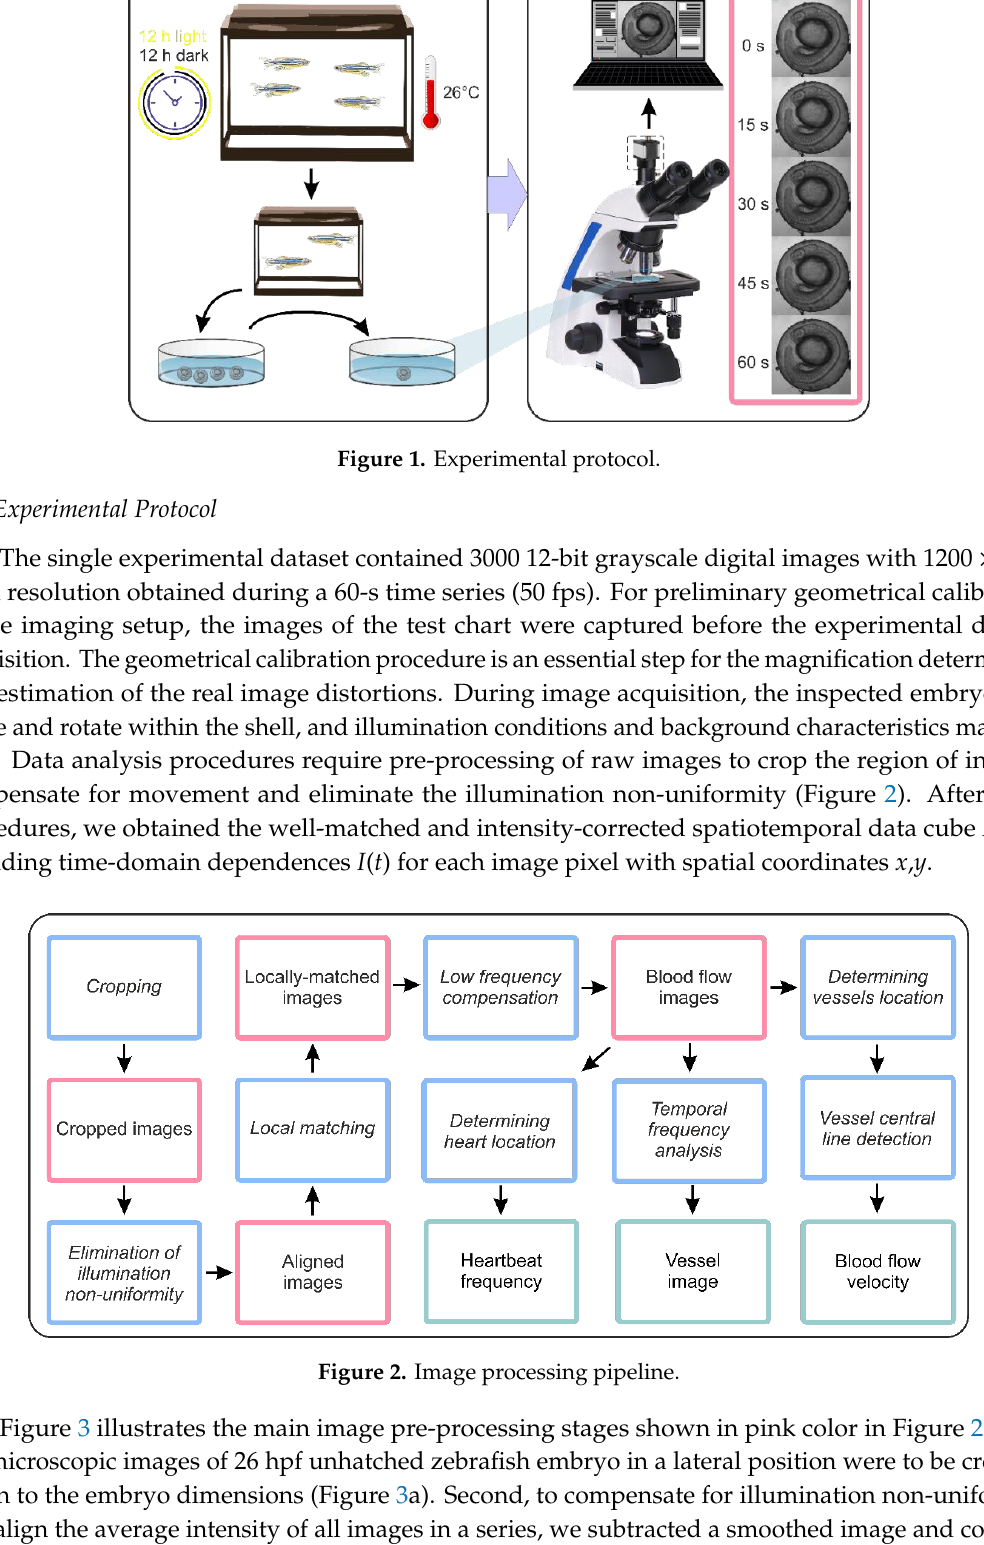
Figure 2. Image processing pipeline.